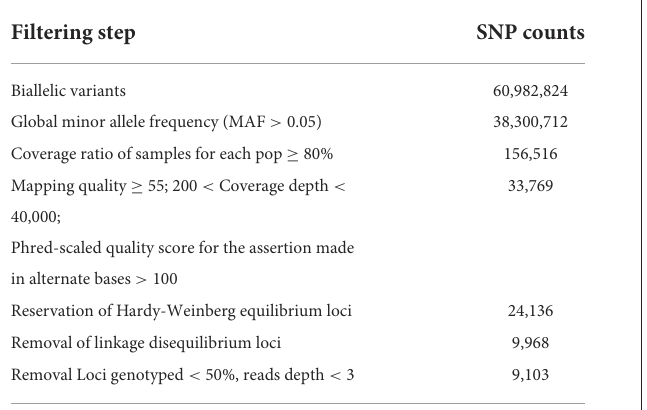
TABLE 2 Summary statistics for counts of putative SNP loci and final counts of candidate SNPs after different filtering steps.